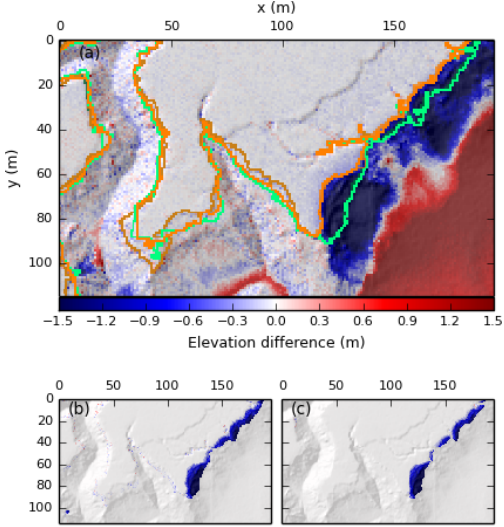
Figure 12. (a) Comparison of marsh areas for a portion of S6 be- tween March (green lines) and October (orange lines) 2007, super- imposed on hillshade data of October 2007. Bright lines correspond to the automatically detected marsh boundary, whereas faded lines correspond to digitised marsh boundaries. Green faded lines are mostly covered by bright green lines. Coloured surfaces indicate el- evation gain or loss between March and October 2007. (b) Map of elevation loss and gain associated to marsh platform evolution, ac- cording to the TIP method. Total volume loss is 1188m 3 . (c) Map of elevation loss and gain associated to marsh platform evolution, according to manual digitisation. Total volume loss is 966m 3